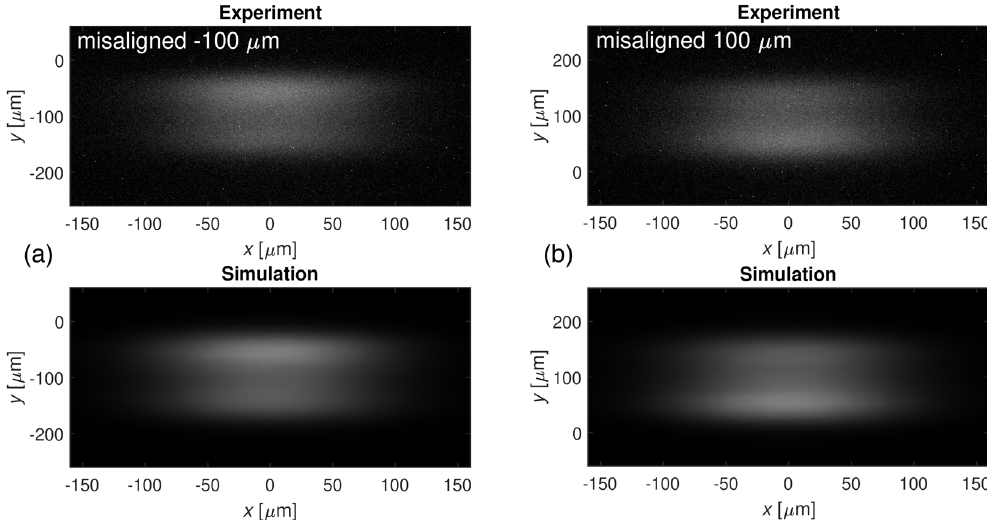
FIG. 10. Images of the pinhole camera from the experiment (top) and the simulation (bottom) with a vertical pinhole misalignment of